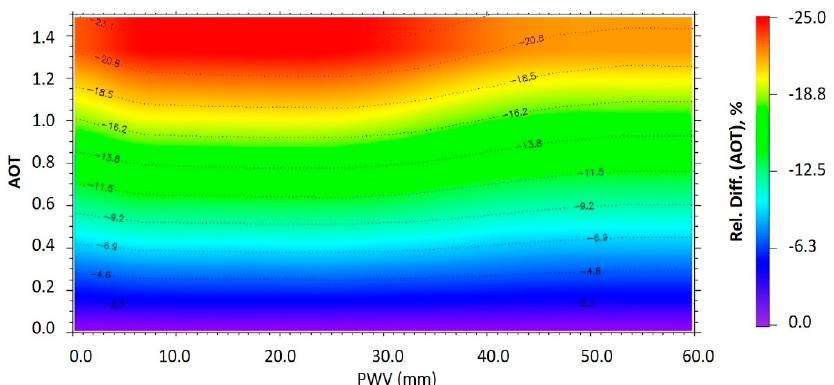
Figure 2. AOT effect (Rel.Dif (AOT), %) estimated by Obregón et al. [24] for each combination of AOT and PWV values.